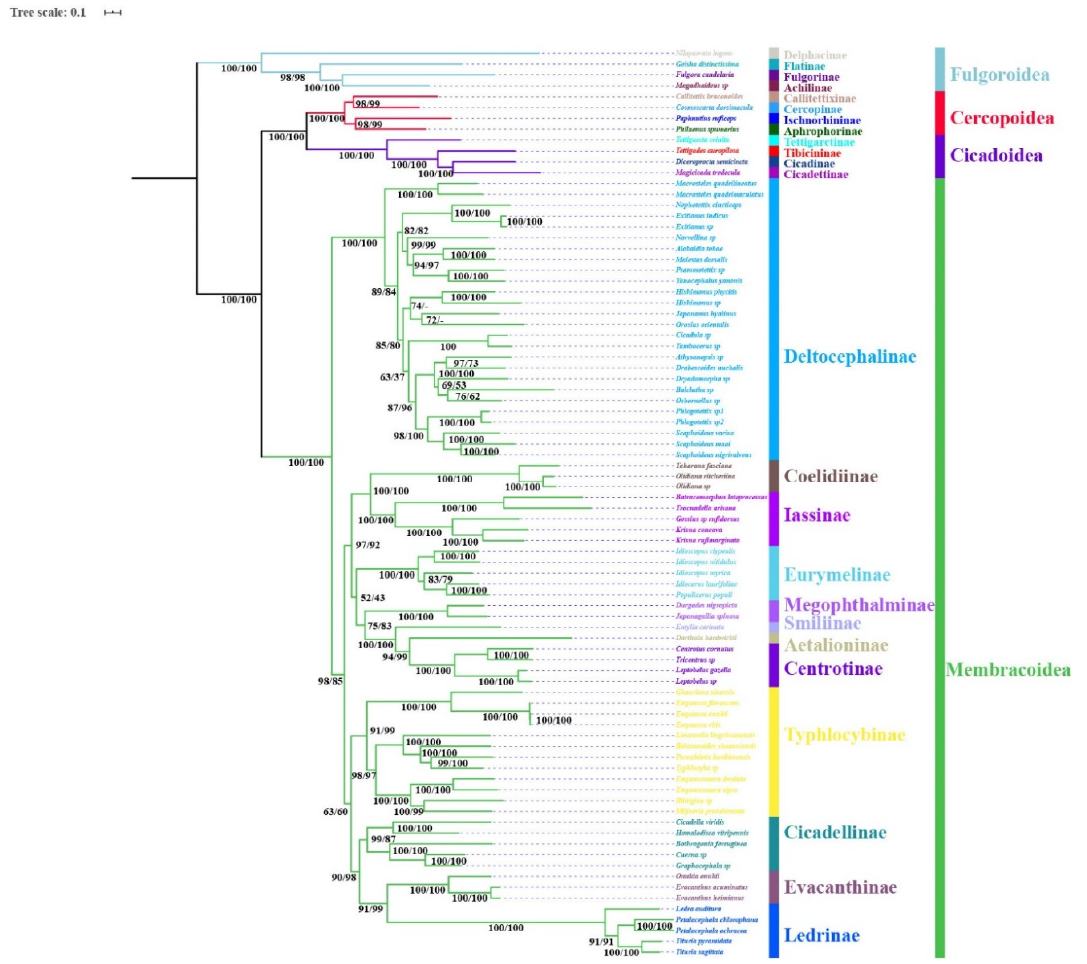
Figure 7. Phylogenetic tree produced using maximum likelihood based on the dataset of P123R/P123. Numerals at nodes are bootstrap support values (BS).